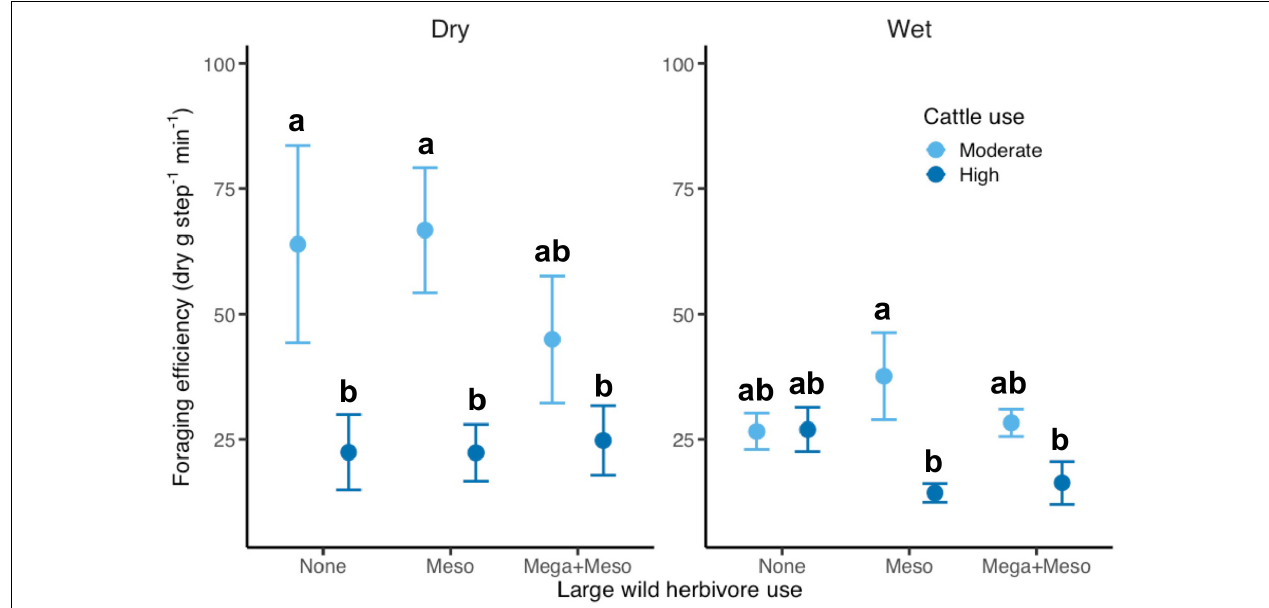
FIGURE 3 | Treatment effects on cattle foraging efficiency across seasons ( M ± 1 SE ). Within each season, treatments not sharing letters are significantly different ( p < 0.05) based on Tukey’s post hoc